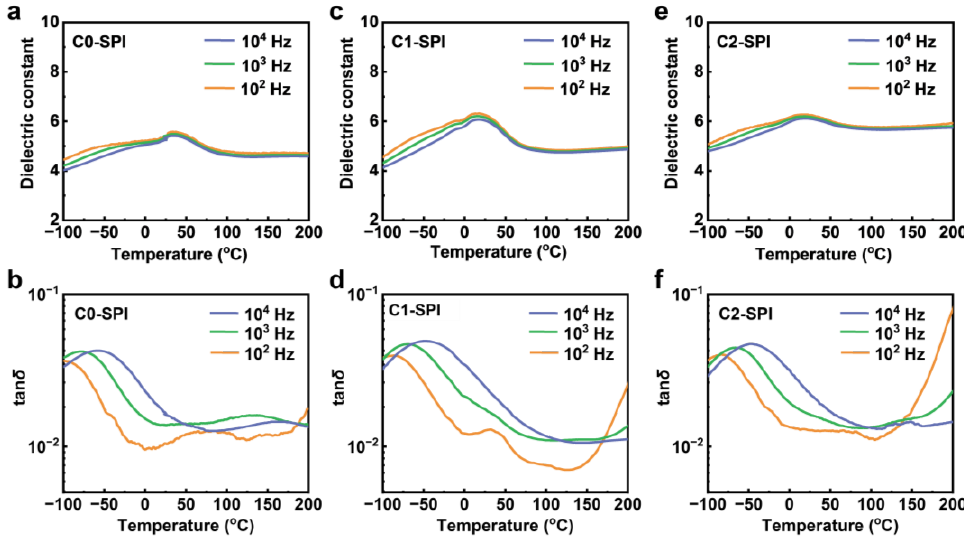
Figure 4. ( a , c , e ) Dielectric constant and ( b , d , f ) dielectric loss versus temperature at various frequen- cies of C0-SPI, C1-SPI, and C2-SPI, respectively.